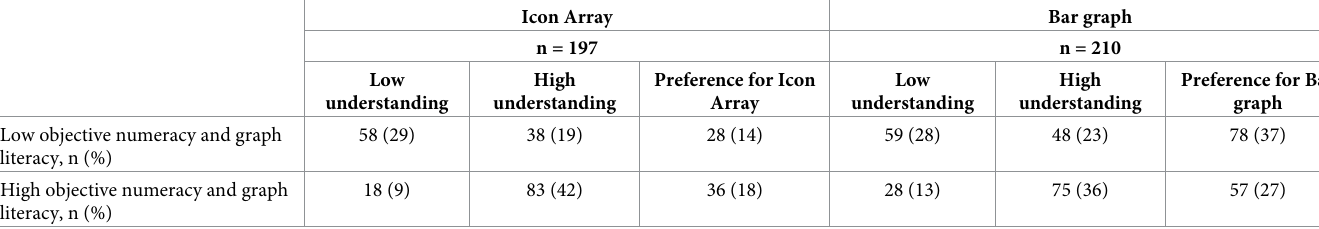
Table 3. Comparison of participants’ understanding and objective numeracy and graph literacy proficiency for each trial